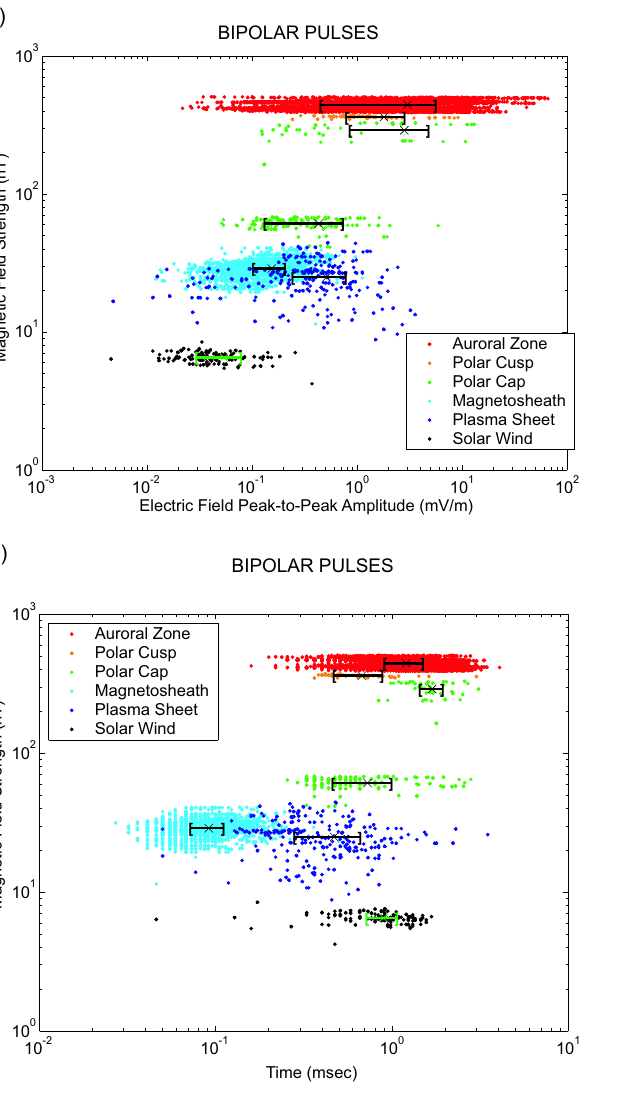
pulses have been omitted.